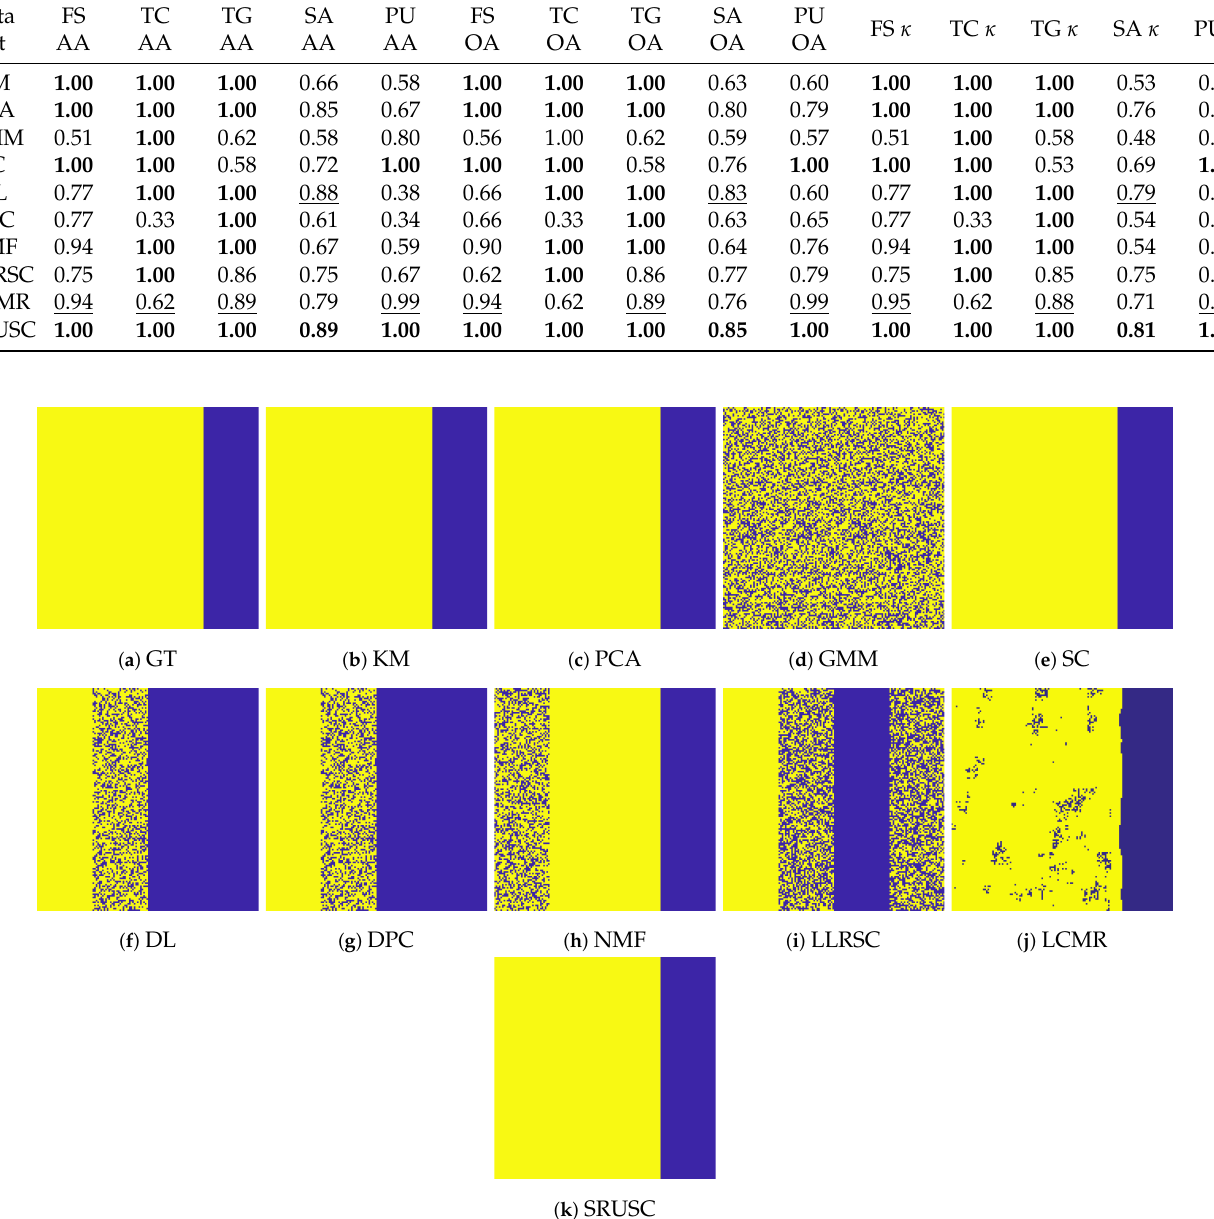
Figure 7. For the four spheres synthetic data set, several methods achieve perfect accuracy, including the proposed method. Interestingly, the proposed unsupervised SRUSC achieves perfect accuracy, while the supervised LCMR algorithm does